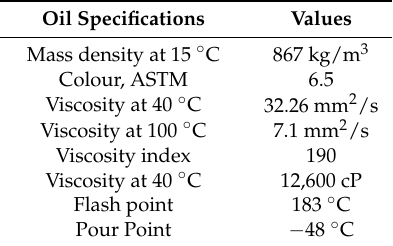
Table 1. Specifications of commercial grade automatic transmission fluid (ATF) used as the lubricating